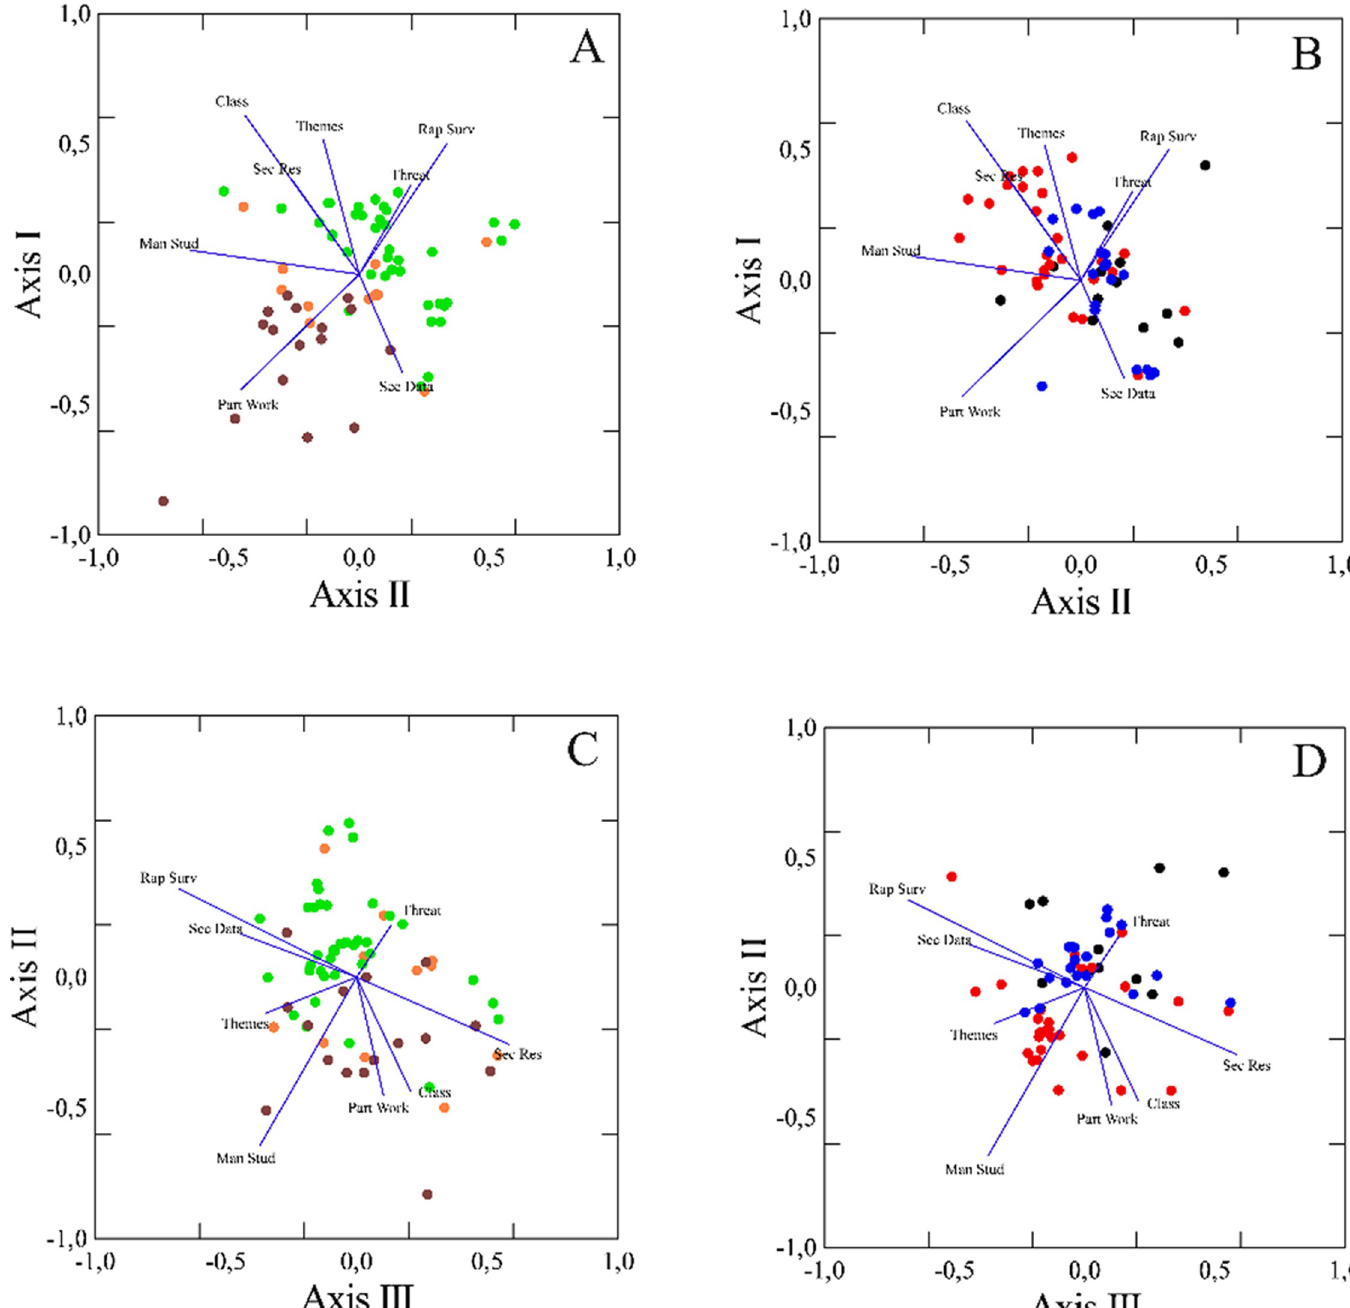
Fig 3. Ordination of Protected Areas (PAs) relative to NMDS Axis I versus II (A and B), and Axis II versus III (C and D). The colors represent PA categories: orange– Environmental Protection Areas; black–Ecological Stations; red–National Forests; green–National Parks; blue–Biological Reserves; brown–Extractive Reserves. Methods: Part-Work–participatory workshops or interviews with residents or beneficiaries; Sec-Data–secondary data on the interior of the PA (little information); Man-Stud– specific management studies; Rap-Surv–primary data from rapid surveys for the MP; Sec-Res–secondary data from PA research programs. Threat—identification of biodiversity threats; Class—classification of PA environments; Themes—integrated analysis of the different diagnostic themes. Axes are scaled according to Pearson’s correlation coefficients (vectors) between each method and the Axis. Due to a large number of overlapping, data points were ’jittered’ on both axes, by adding random noise to their